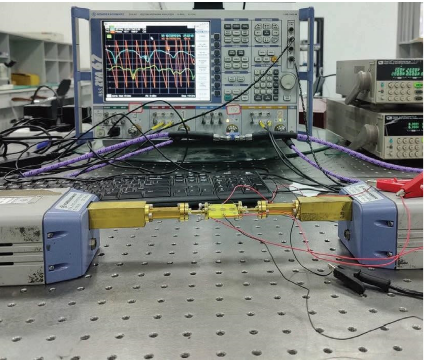
Figure 8: Te test diagram of the phase shifter.